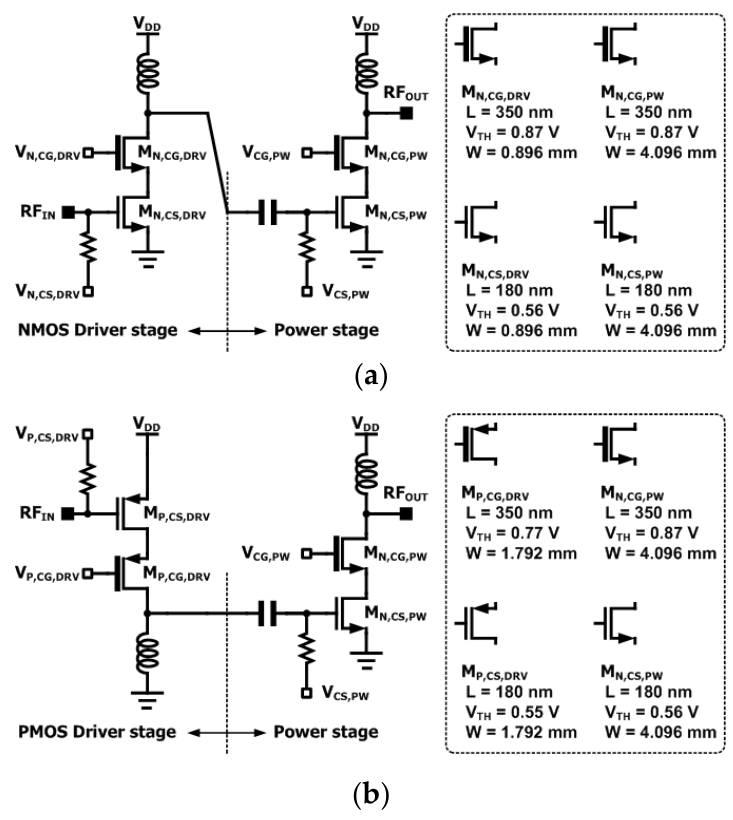
Figure 6. Simplified schematic of PA (V DD = 3.3 V): ( a ) n-channel metal oxide semiconductor (NMOS) driver stage, ( b ) p-channel metal oxide semiconductor (PMOS) driver stage.